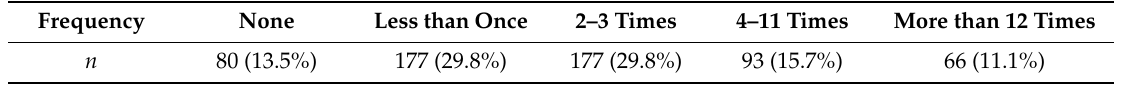
Table 2. Frequency of witnessing animal abuse cases per year ( n = 593).